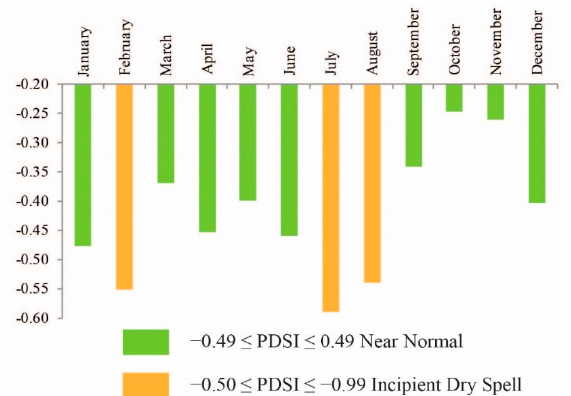
Figure 8. The monthly distribution of the mean monthly Palmer Drought Severity Index for Hungary and Vojvodina presented jointly during the period 1920–2014.